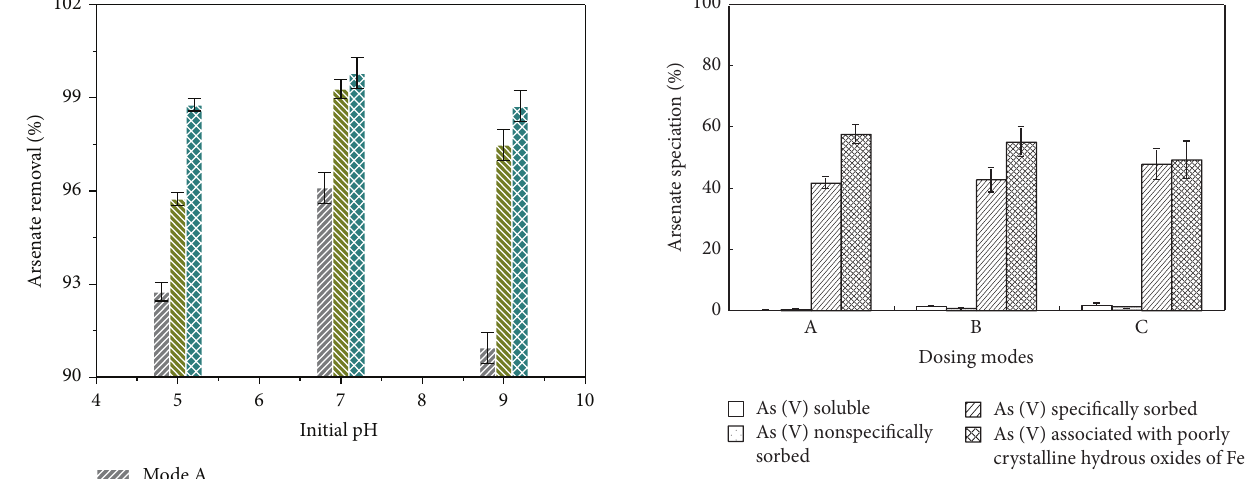
Figure 3: Percentage of As (V) extracted with a sequential extrac- tion procedure from the Fe-As (V) samples in the different dosing = 7.0 ). modes (pH Initial